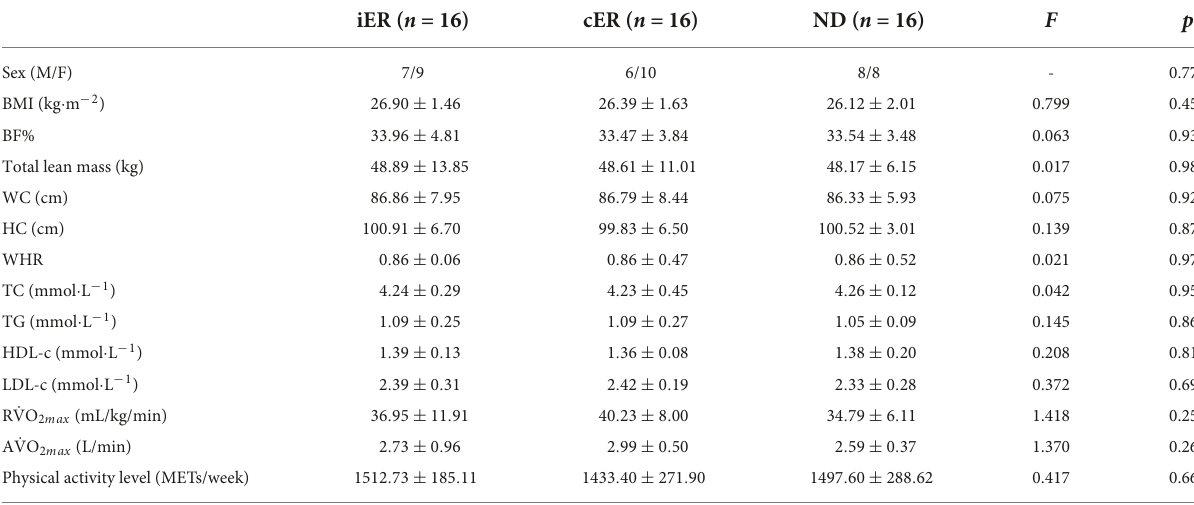
TABLE 2 Baseline